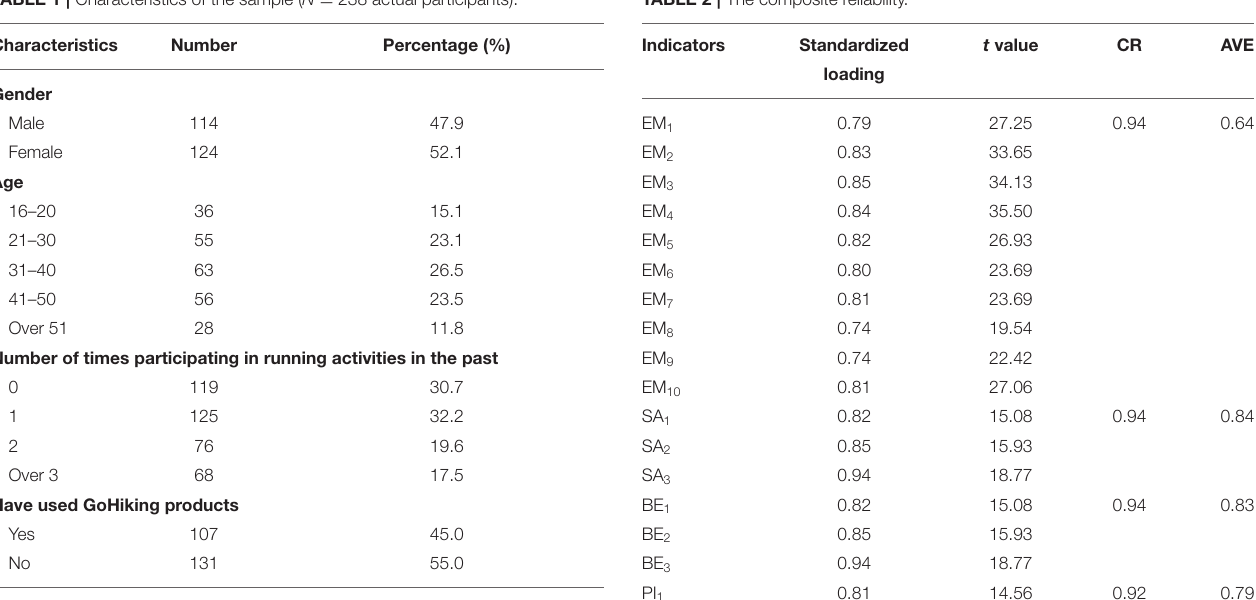
TABLE 2 | The composite